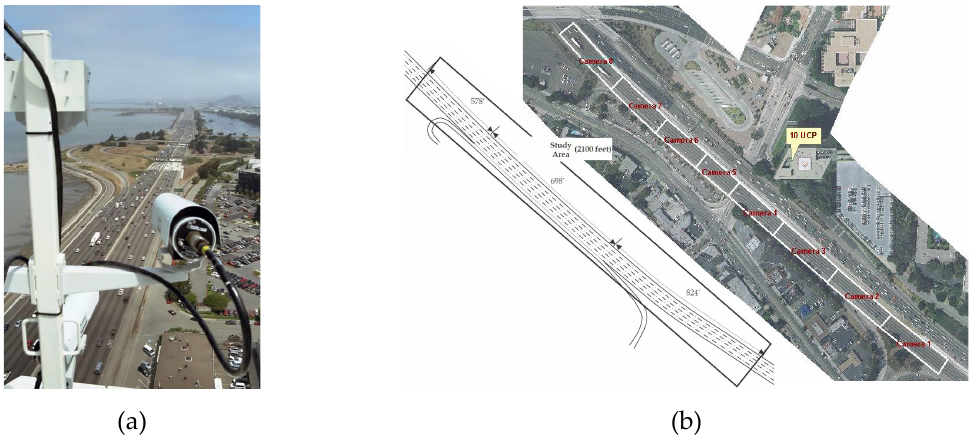
Figure 7. Experiment dataset for training the proposed method and comparison with other methods: ( a ) Vehicle trajectories were collected for NGSIM using digital video cameras; ( b ) dataset including mild, moderate, and congested traffic conditions on the